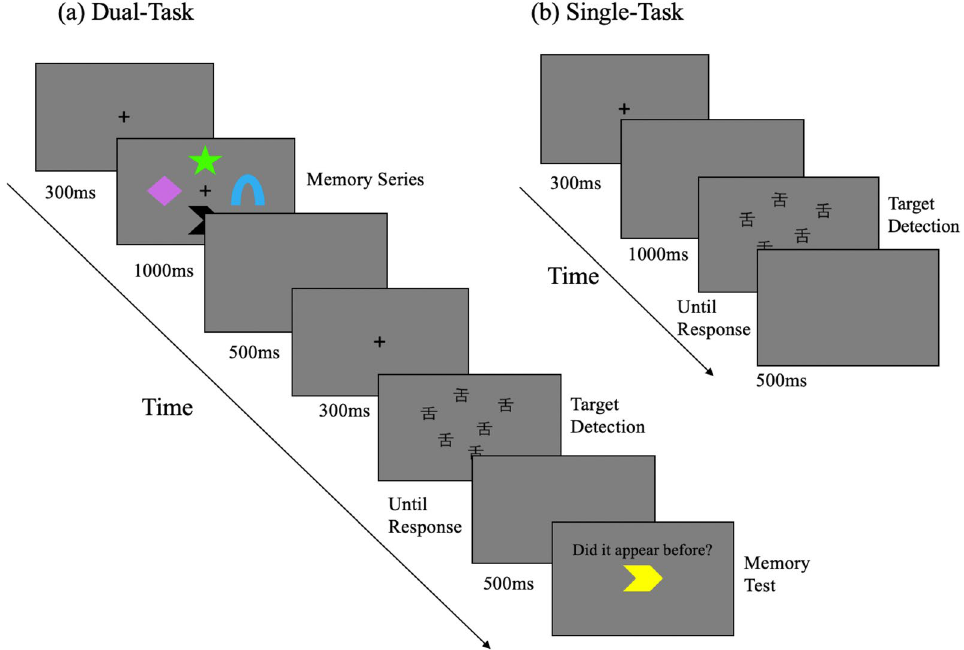
Figure 4. Timeline showing the procedure for a single trial in Experiment 2. ( a ) The dual-task condition including a visual search task and a memory task. ( b ) The single-task condition is a purely visual search